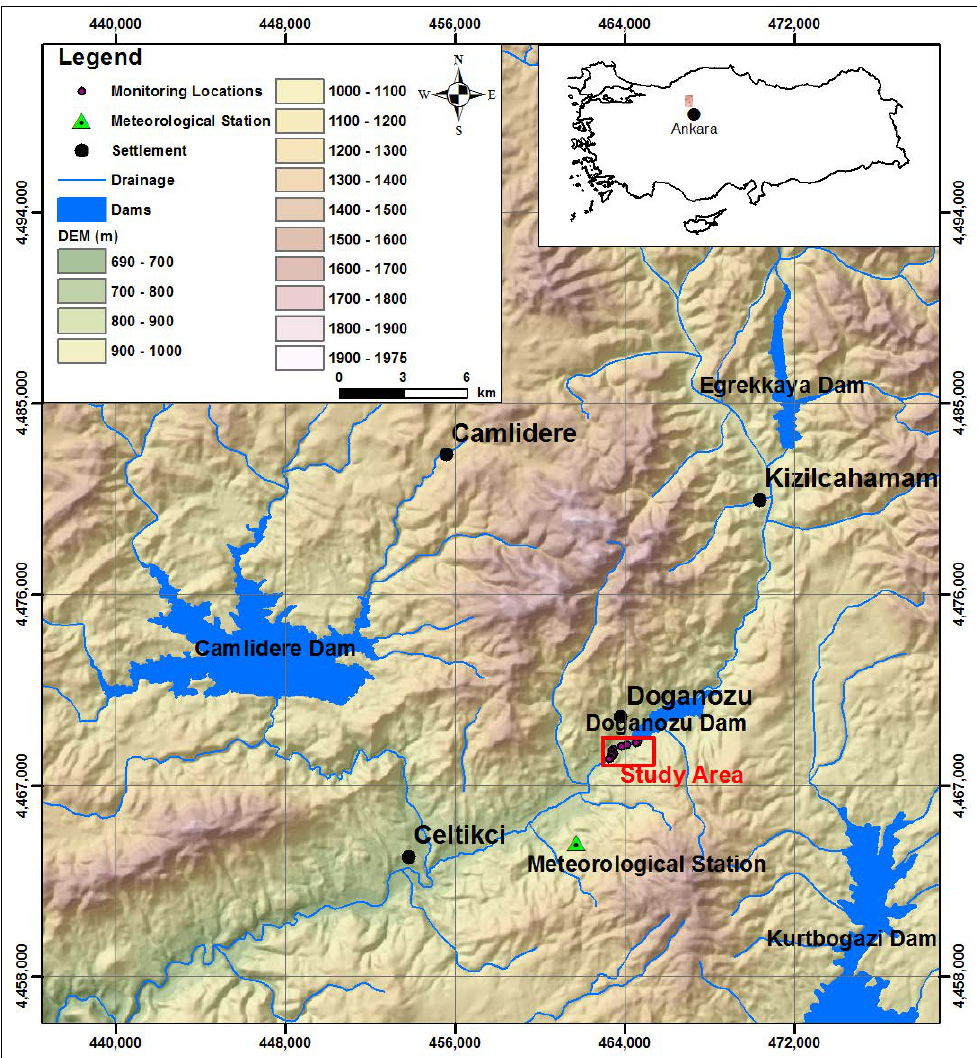
Figure 1. Regional view of the study area.